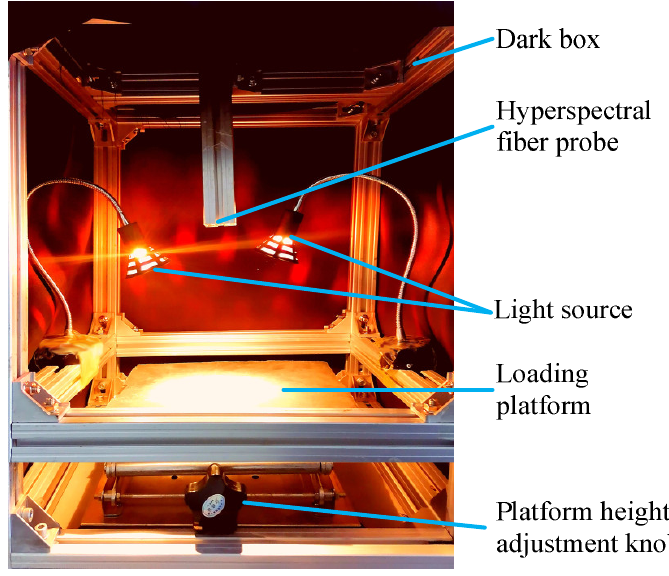
Figure 2. Laboratory data acquisition device.